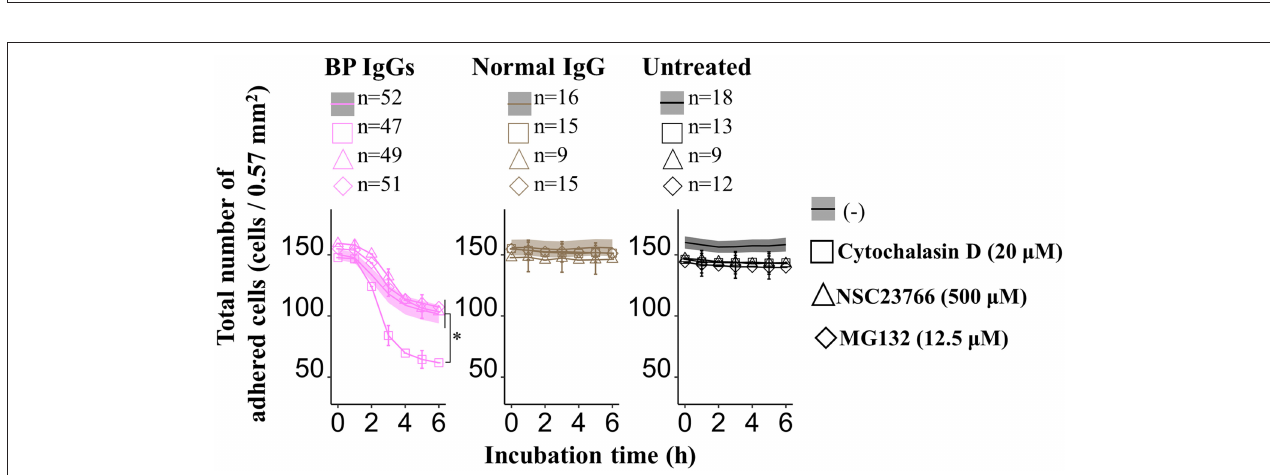
FIGURE 9 | the fluorescence intensity, and XZ slice indicates the longitudinal slice. (B) Fluorescence microscopy images of the binding of the indicated IgGs to the NHEKs at 2h. NHEKs were pretreated with cytochalasin D (2 µ M) for 30min, NSC23766 (200 µ M) for 1h, or MG132 (6.25 µ M) for 0h, and then 2 mg/ml BP IgGs (BP-1, BP-2, BP-3) or normal IgG were added to the cultured cells. The 3D reconstruction assay was applied to observe the changes. Scale bar 5 µ m. (C) Quantification of the IgG-stained dots in cells. The anti-IgG-FITC-stained dots in the cytoplasmic region of individual cells were counted using the CellProfiler image analysis software. One-way ANOVA was used for the statistical analysis. * p -value < 0.05.